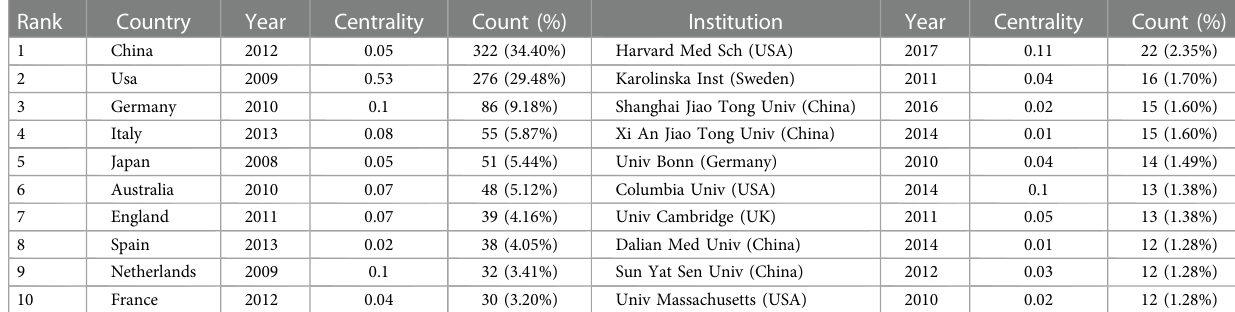
TABLE 2 Top 10 countries/regions and institutions related to “ in fl ammasome AND atherosclerosis ” .